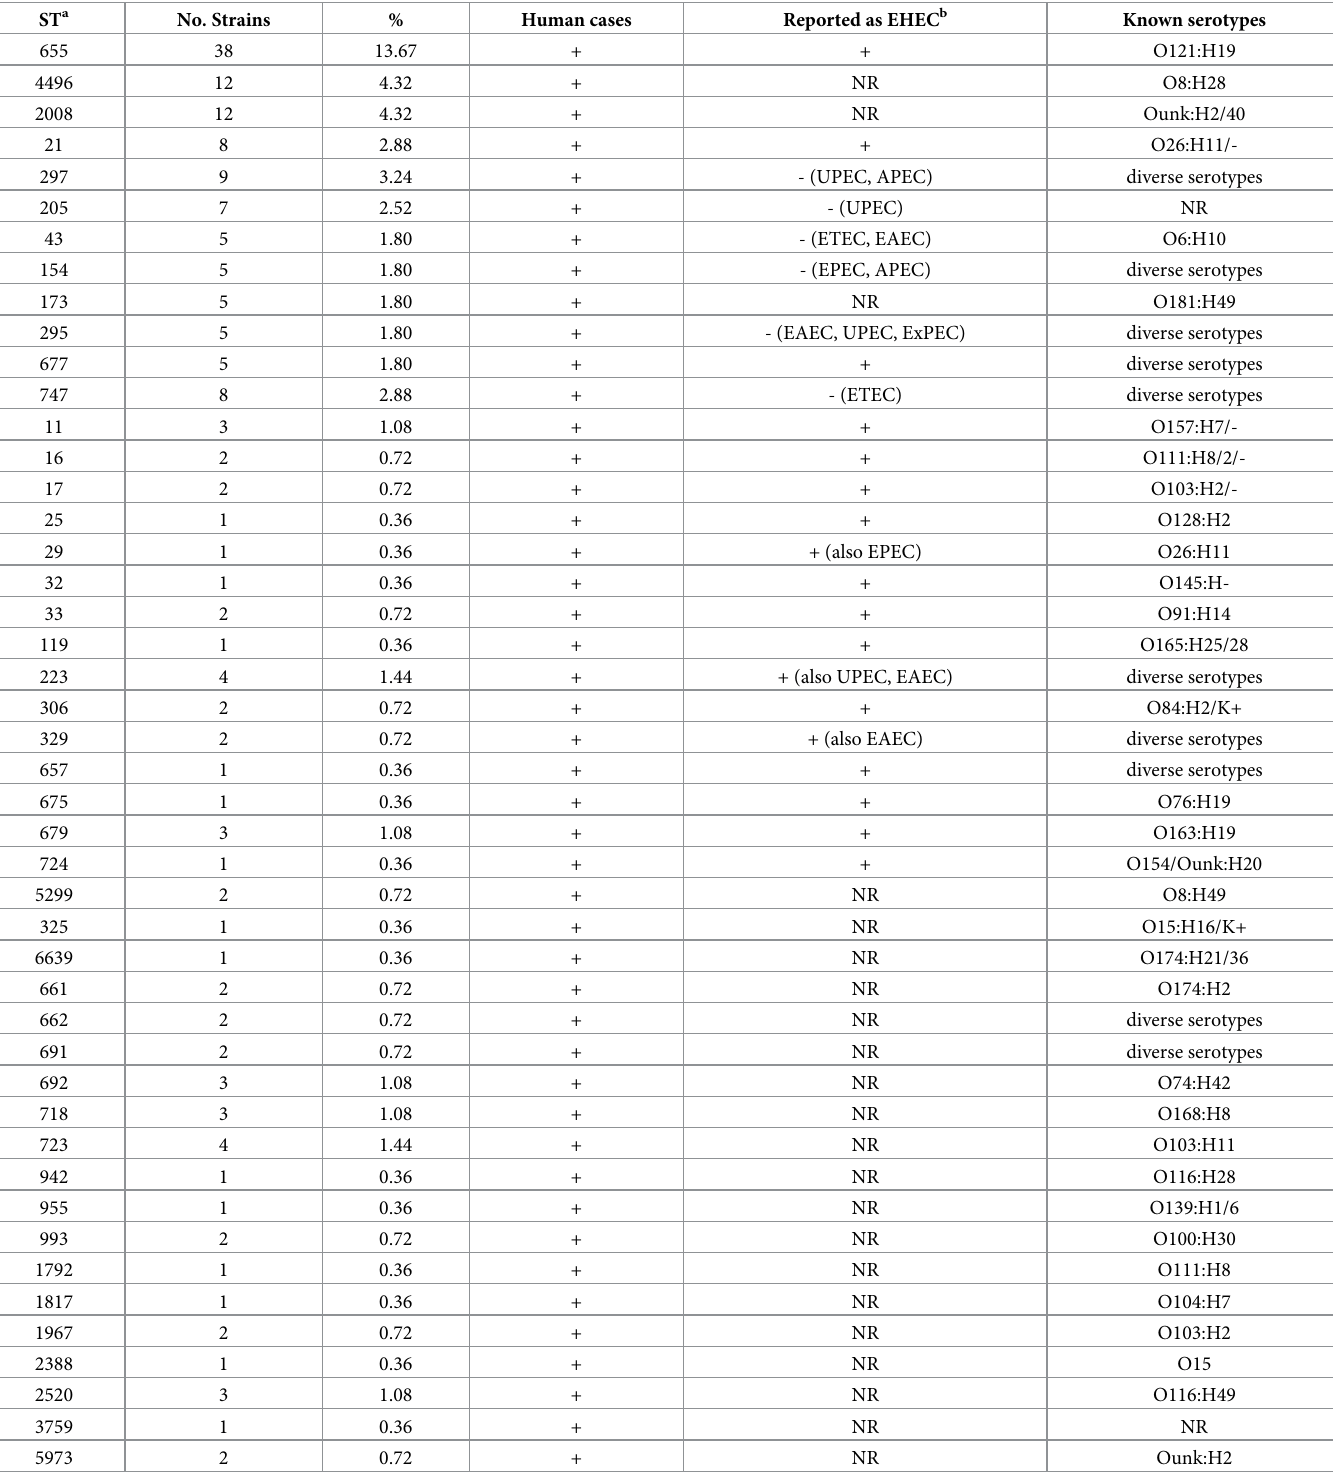
Table 3. STs observed and number of strains included in each ST. Additionally information is provided for strains belonging to those STs such as: link to human cases, link to EHEC cases, and known serotypes. These additional reports are based on what it is reported in the E . coli section of the Enterobase database (http://enterobase.